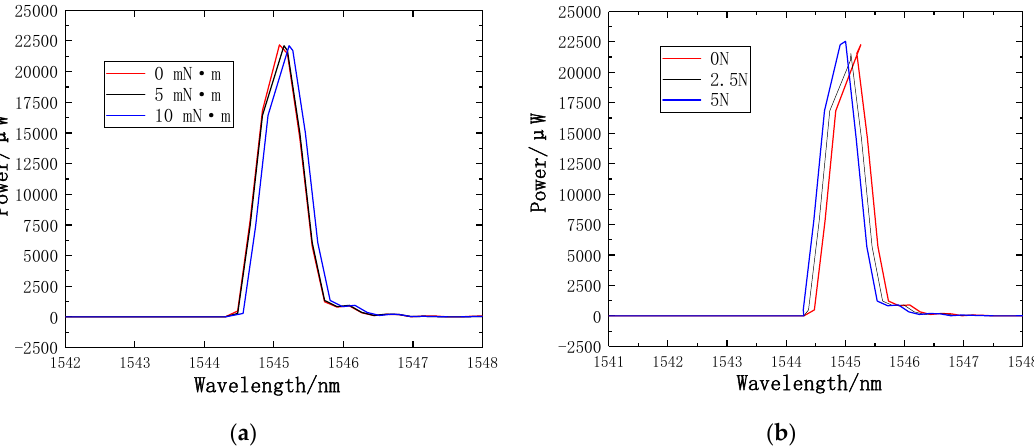
Figure 19. Transmission spectra of the FBGs: ( a ) Transmission spectra of torque; ( b ) Transmission